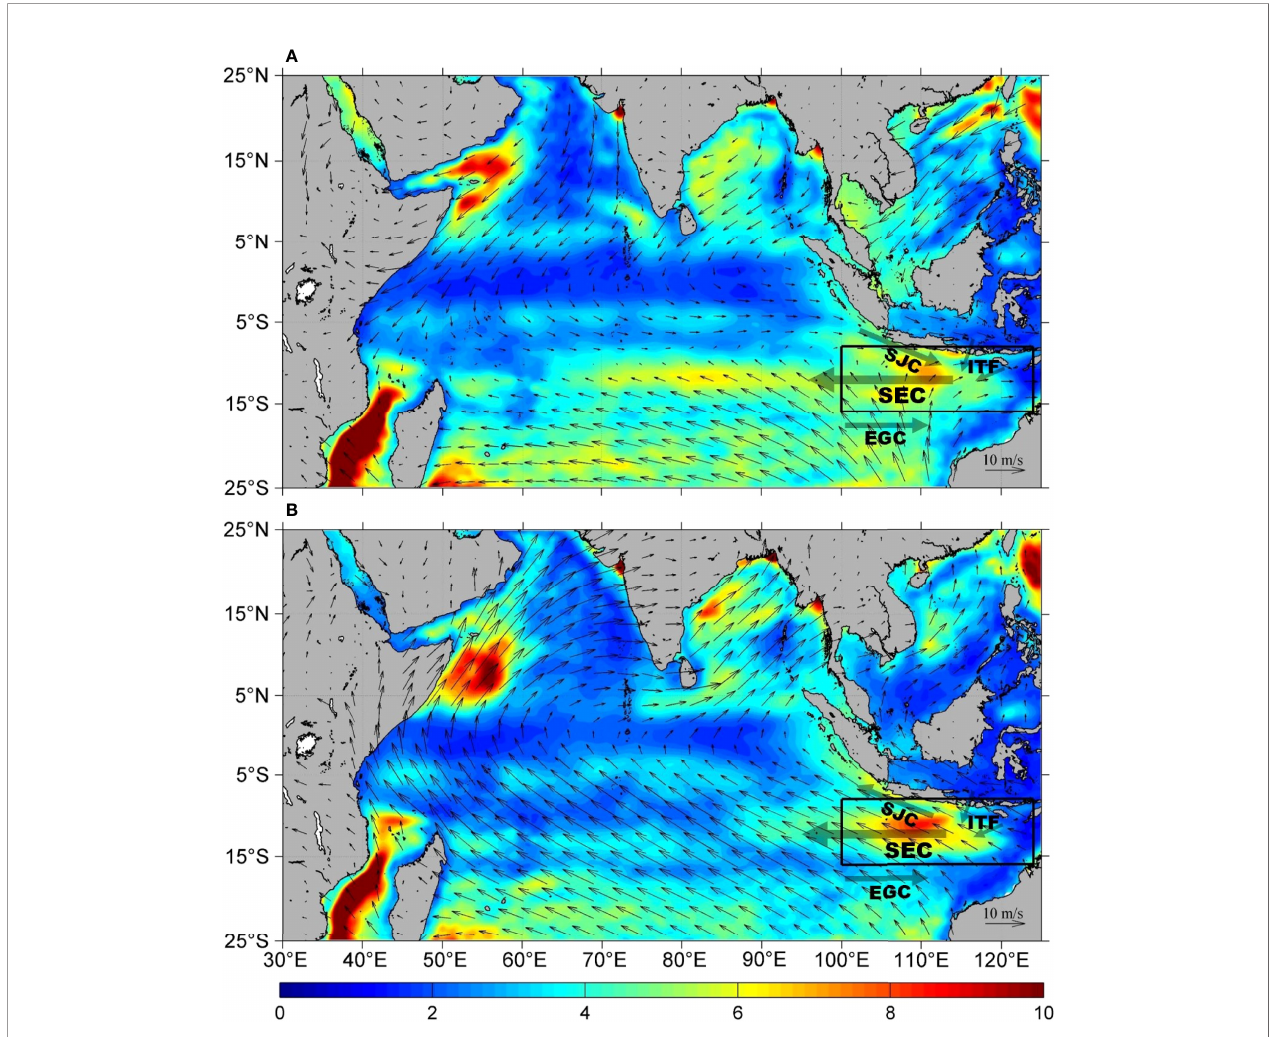
FIGURE 1 | Austral summer [ (A) ; December to February] and winter [ (B) ; June to August] wind (vector; unit: m/s) patterns from ERA5 dataset with overlapping the standard deviation of 30 – 120 days band-pass – fi ltered SLA (unit: cm) derived from AVISO in corresponding season. The black box indicates the study area. Primary ocean currents in the study region are shown as semitransparent black solid arrows [revised from Yu and Potemra (2006) and Yang et al. (2015)]: the South Java Current (SJC), the South Equatorial Current (SEC), the Indonesian Through fl ow (ITF), and the Eastern Gyral Current